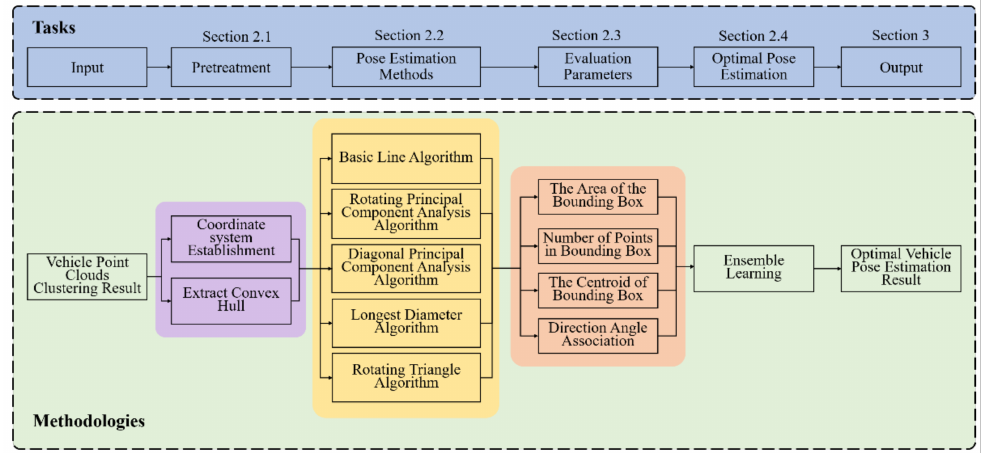
Figure 3. Overall flow chart. In Section 2.1, the preprocessing method is proposed. Section 2.2 presents five different pose estimation methods. Section 2.3 presents four indexes for evaluating pose estimation methods from the time and spatial dimensions. In Section 2.4, the TS-OVPE network is proposed, and introduces the network’s structure is introduced. Section 3 presents tests of the proposed algorithm in a public dataset and our experimental